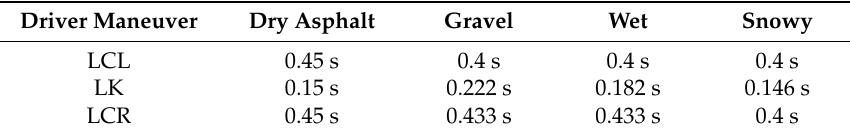
Table 6. Average time delay for correct